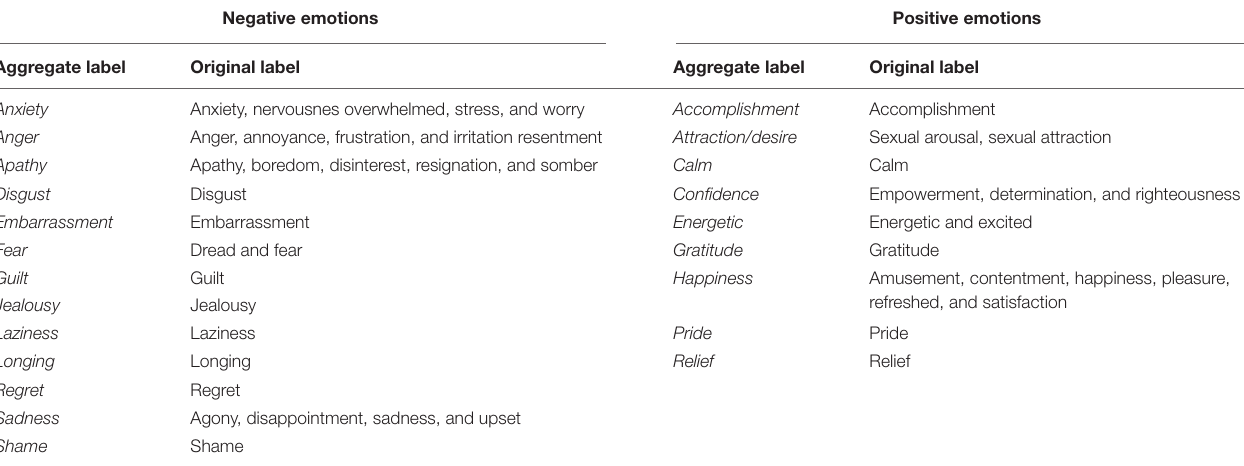
TABLE 1 | Summary of changes to emotion